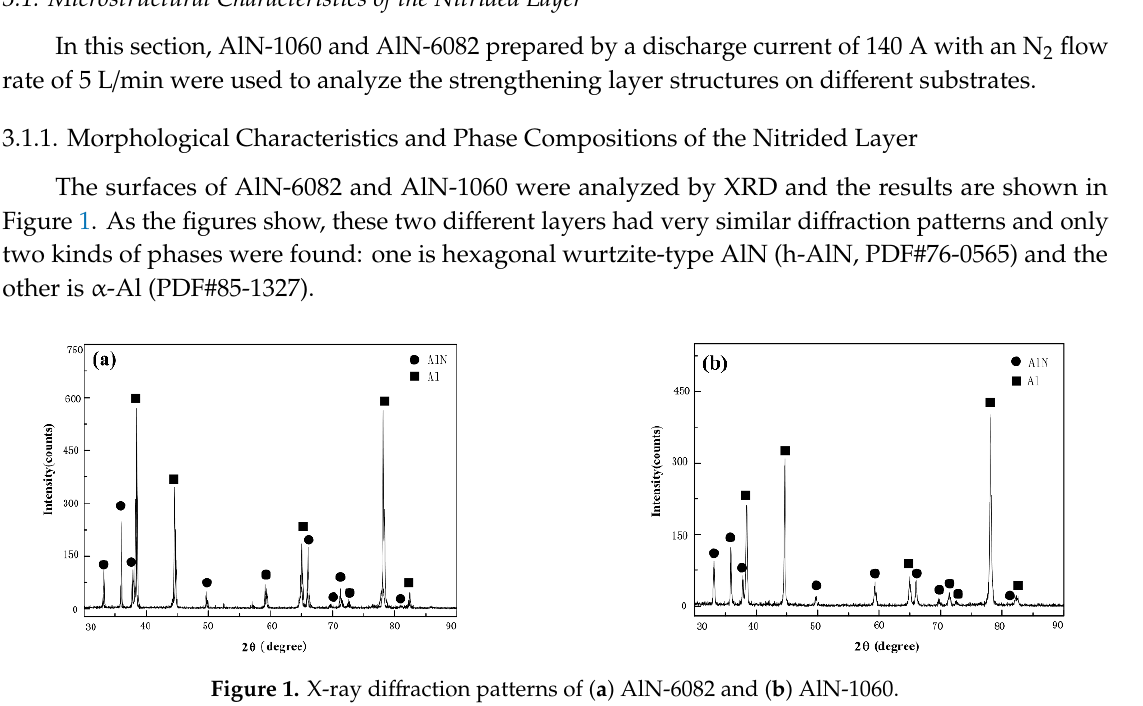
Figure 2. A typical cross-sectional picture of the nitrided layer.